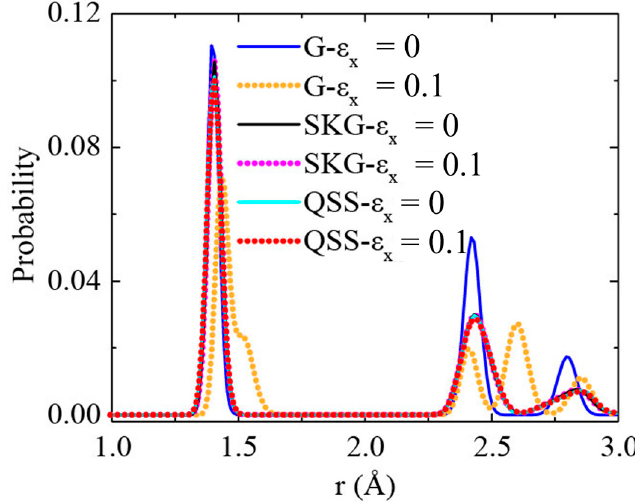
Figure 8. The radial distribution function of carbon atoms of graphene (G), SKG, and QSS models at strain-free and strain at 0.1. ε x represents the uniaxial tensile strain in the x-direction.